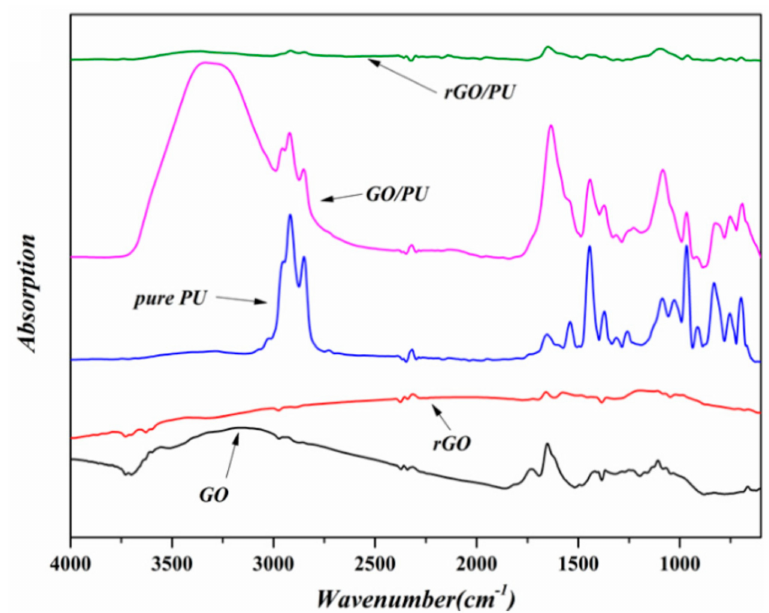
Figure 3. Fourier-transform infrared (FT-IR) of the graphene oxide (GO), reduced graphene oxide (rGO), pure polyurethane (PU), graphene oxide / polyurethane (GO / PU) and reduced graphene oxide / polyurethane (rGO / PU) composite foam.